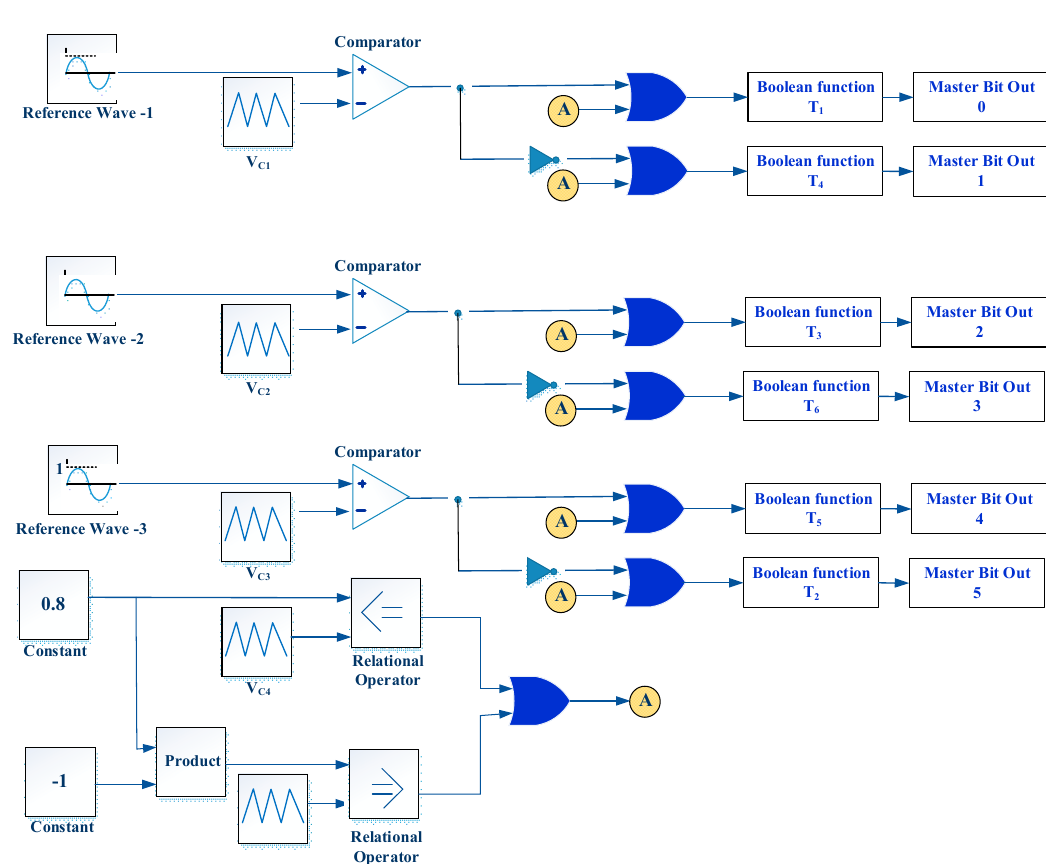
Figure 20. SPWM generated after driver circuit.